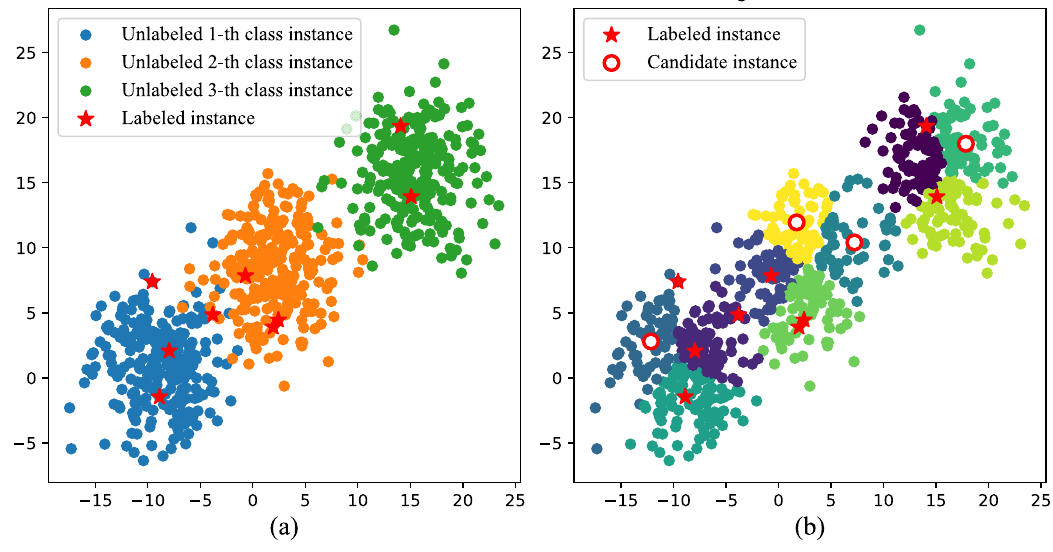
Figure 2. Example of candidate subset selection. Subfigure ( a ) shows a three-class synthetic ordinal dataset of 800 instances, with 9 labeled instances in the current iteration. To obtain a candidate subset, we use the k -means algorithm to divide the data into 10 clusters. Then, we take the centroids of clusters containing no labeled instances as candidate instances. Subfigure ( b ) shows the result of candidate subset selection. We can see that there are 4 candidate instances in the current